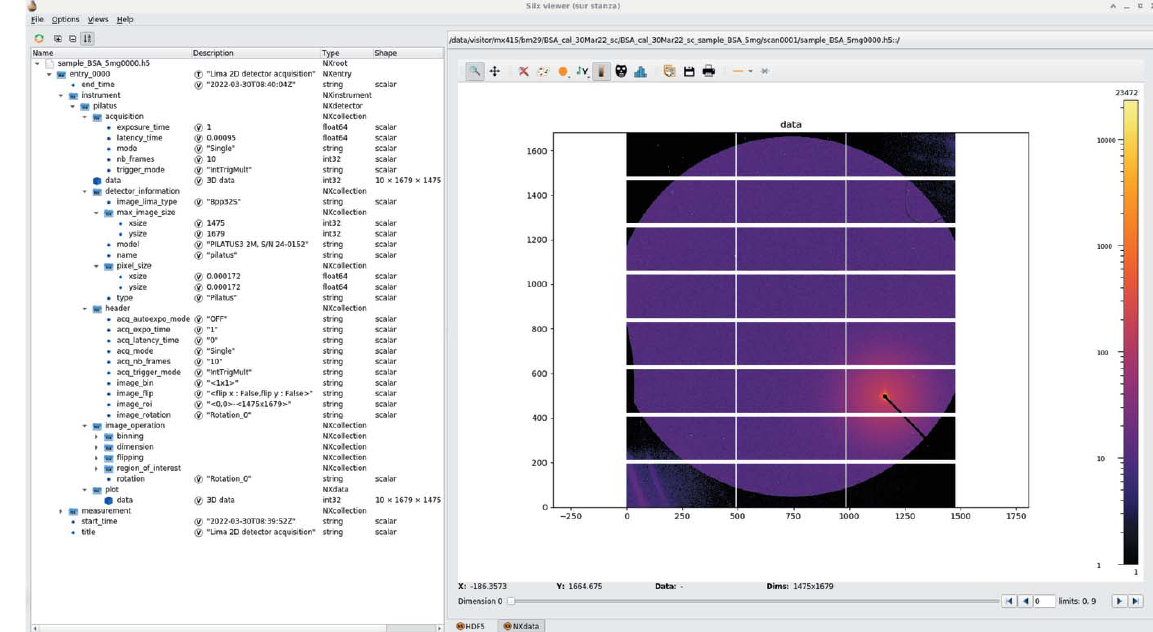
Figure 2 Layout of a raw image HDF5 file produced by the LIMA acquisition software and visualized with the silx